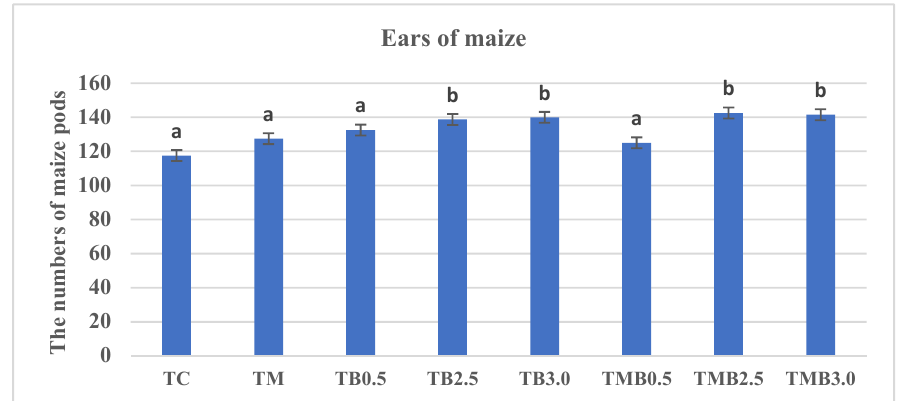
Figure 1. The number of ears of maize from different experimental plots. Remark: data shown as the mean ± SE with harmonic mean sample size = 4.000. The different letters represent a statistically significant difference in the data at p < 0.05.